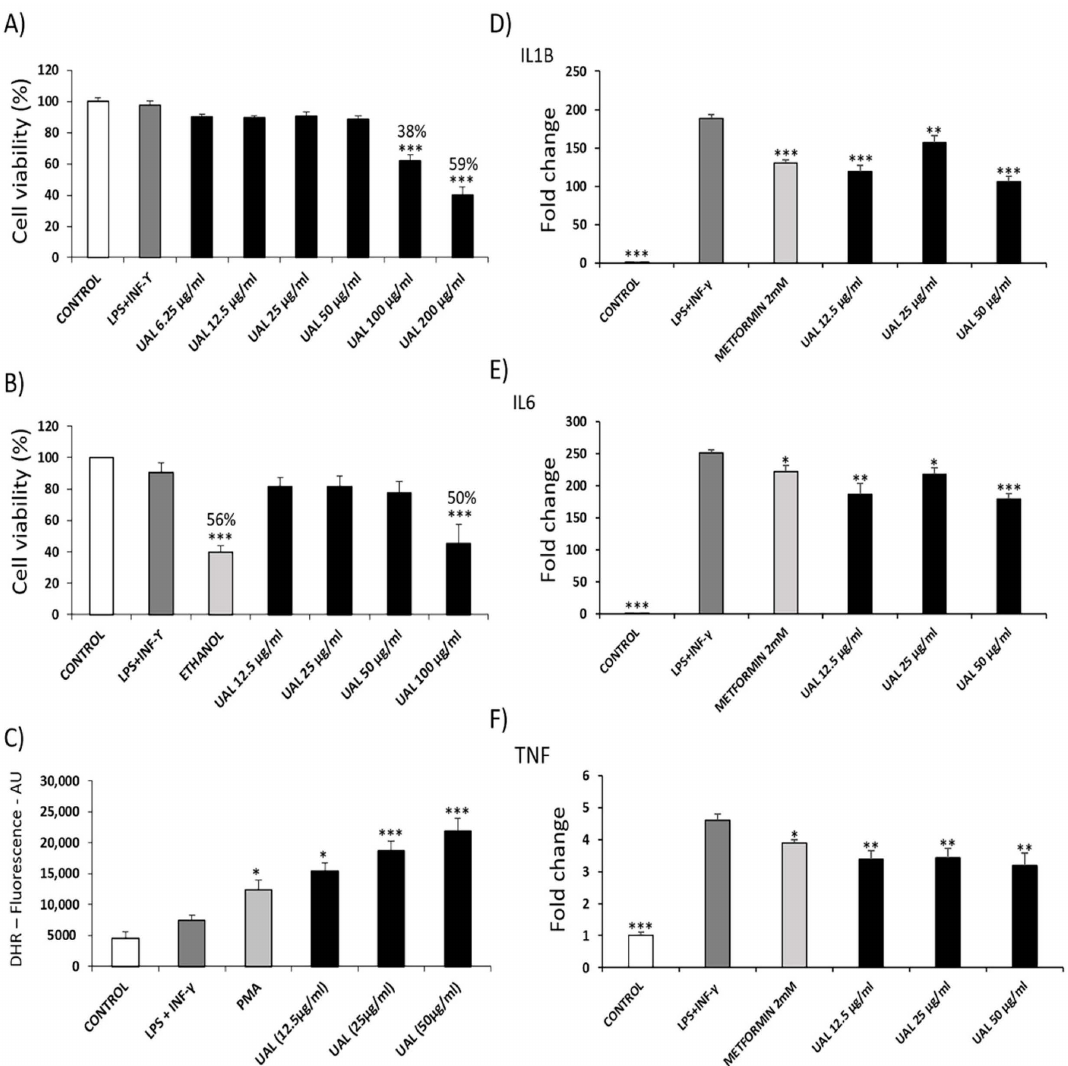
Figure 1. Effect of ursolic acid lactone (UAL) on cell viability, oxidative burst, and the expression of pro-inflammatory genes in activated J774A.1 macrophages. ( A ) J774A.1 cells were activated for 18 h and treated with various doses